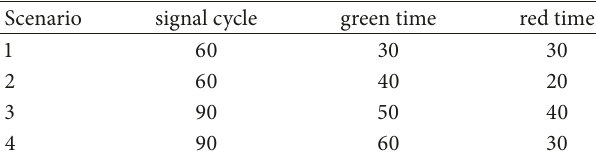
Table 4: The four scenarios of signal